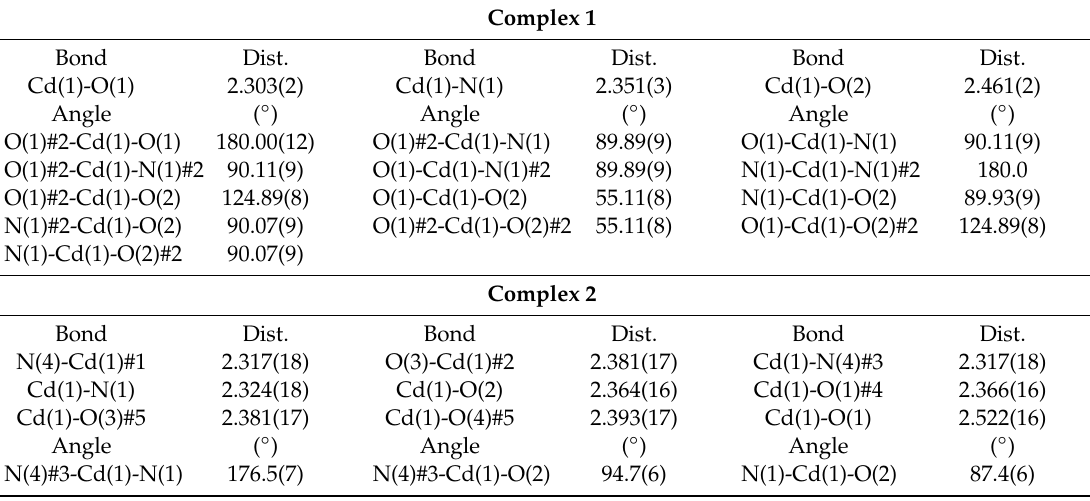
Table 2. Selected bond lengths (Å) and bond angles ( ◦ ) of complex 1 , 2 , and 3 . Complex 1 Bond Dist. Bond Dist. Bond